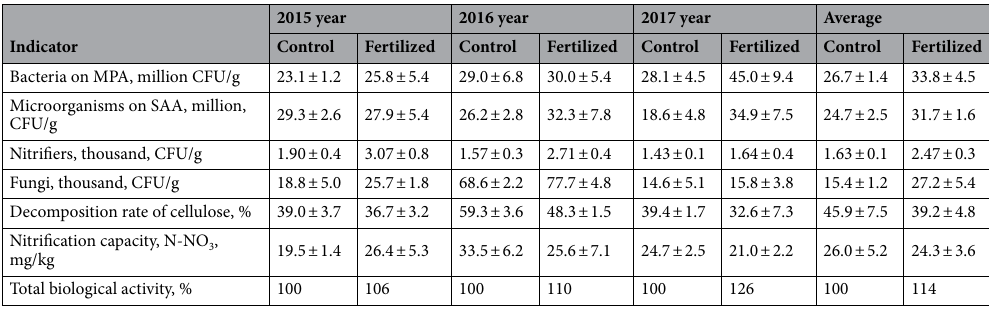
Table 1. Biological activity of irrigated meadow-chernozem soil under perennial grasses at different levels of